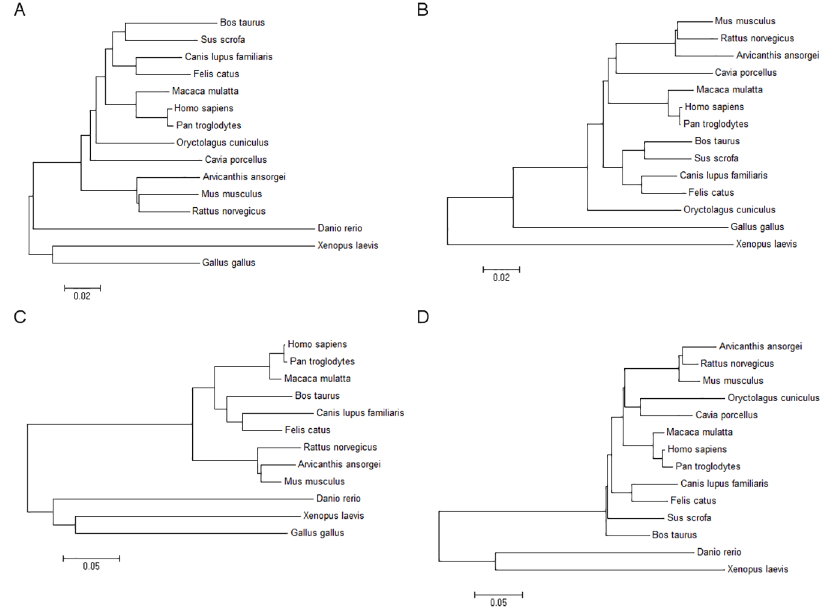
Fig 2. Phylogenetic analysis for retinal genes. Multiplesequencealignmentfor the CDS of A) rhodopsinB) short-wave-sensitiveopsin 1 C) melanopsin D) cone-rodhomeobox for A . niloticus and other model organisms performed using MUSCLE. The Maximum Composition Likelihoodmodel was used to construct Neighbor-Joiningphylogenetic trees.